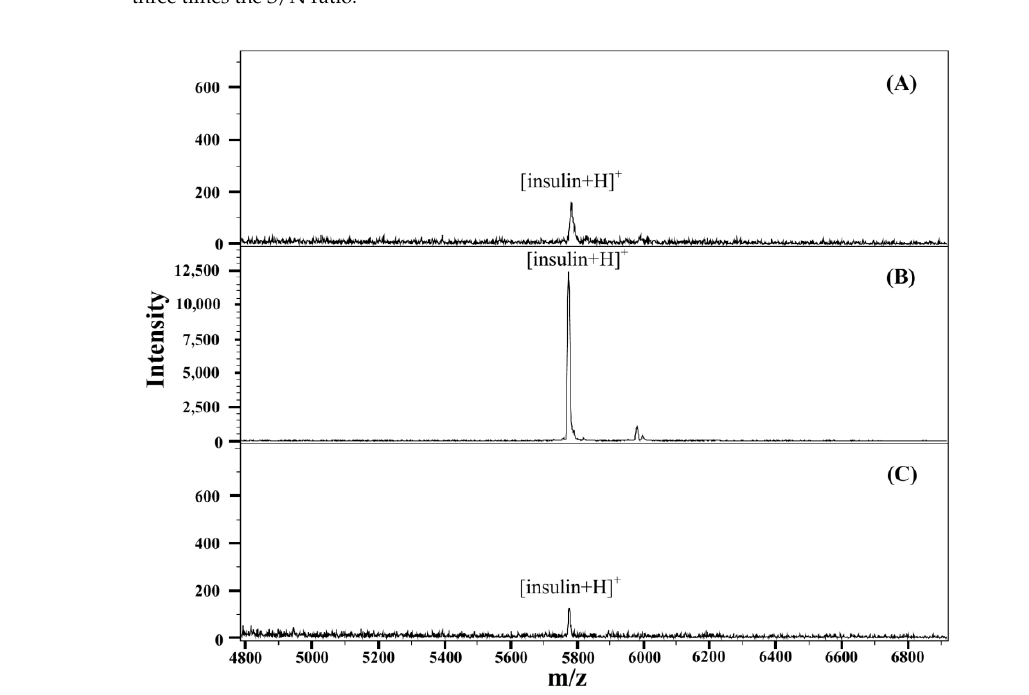
Figure 6. Effect of ( A ) the applied voltage, ( B ) the sample volume, ( C ) the agitation rate, and ( D ) the